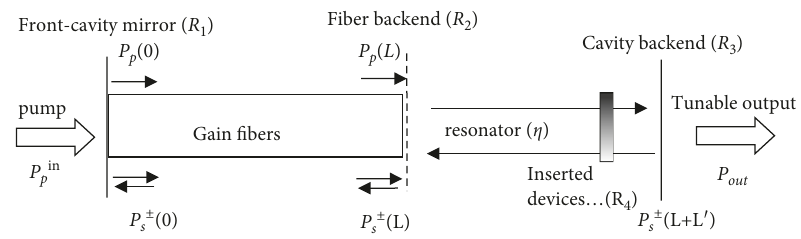
Figure 2: The framework of a simplified tunable fiber laser